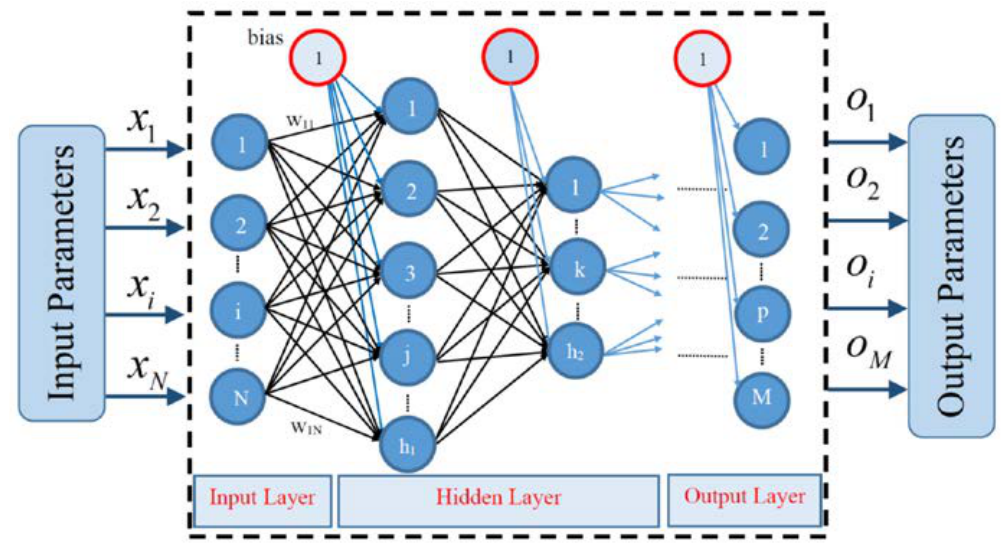
Fig. 1: S tructure of the MLP-feedforward Fig. 1: Structure of the MLP‐feedforward network